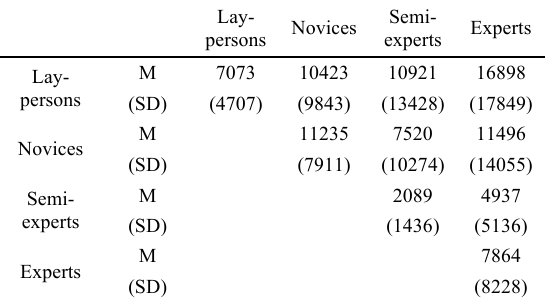
Table 6. Mean values and standard deviations of the distances between the expert groups in the sculpture Daphne.